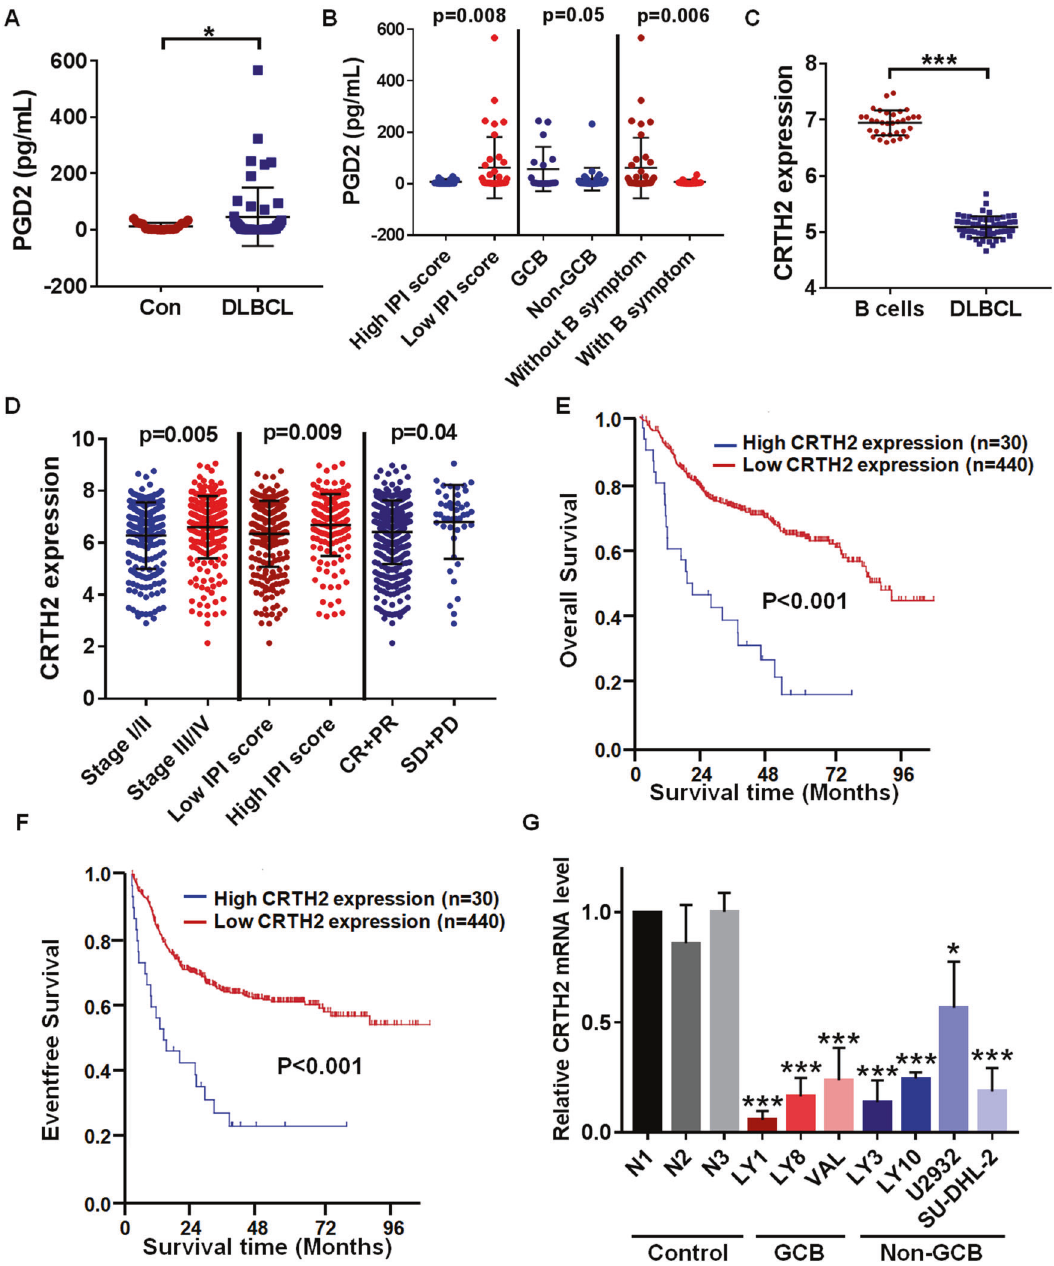
Fig. 1 Elevated serum PGD2 and decreased expression of CRTH2 were correlated with DLBCL progression. A The concentration of serum PGD2 was higher in DLBCL patients ( n = 53) than healthy controls ( n = 19). B We compared serum PGD2 concentration in DLBCL patients grouped according to IPI score, GCB subtype and B symptom, and found the association between serum PGD2 concentration and clinical features in DLBCL patients ( n = 53). C Analysis of GSE56315 dataset showed the decreased mRNA expression level of CRTH2 in DLBCL patients. D To compare the expression of CRTH2 in DLBCL patients grouped according to stage, IPI score and therapeutic ef fi cacy, analysis of GSE31312 dataset found the association between CRTH2 expression and clinical features in DLBCL patients. E , F Kaplan – Meier survival analysis showed the association between CRTH2 expression and OS and EFS in DLBCL patients, respectively. G RT-PCR results showed decreased expression of CRTH2 in DLBCL cell lines, including three GCB cell lines (LY1, LY8, VAL) and four non-GCB cell lines (LY3, LY10, U2932, and SU-DHL-2), in comparison with CD19 + B cells from PBMCs of three healthy donors (three time points). The expression of CRTH2 in healthy control (N1) was adjusted to 1. Data are shown as the mean ± SD. * p < 0.05; ** p < 0.01; *** p < 0.001. Abbreviations: DLBCL diffuse large B-cell lymphoma, GCB germinal center B-cell-like, IPI international prognostic index, CR complete remission, PR partial remission, SD stable disease, PD progressive